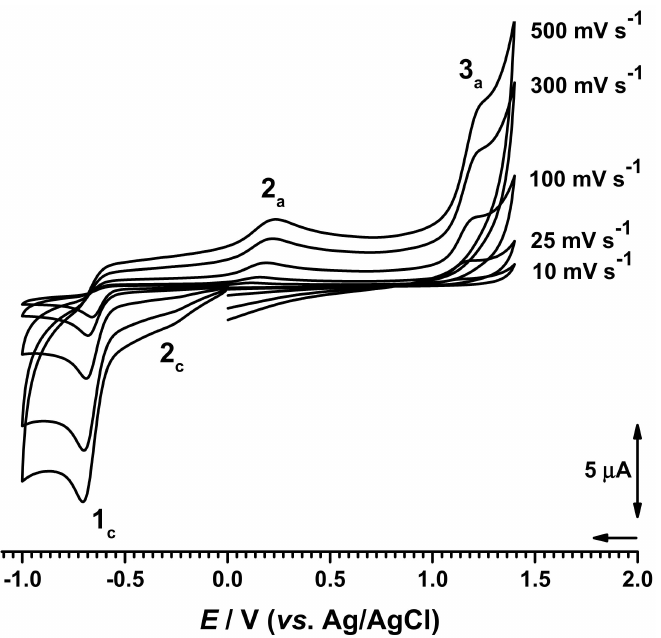
Figure 2. Cyclic voltammograms at different scan rates in 500 µ M AZA in phosphate buffer (0.1 M, pH =